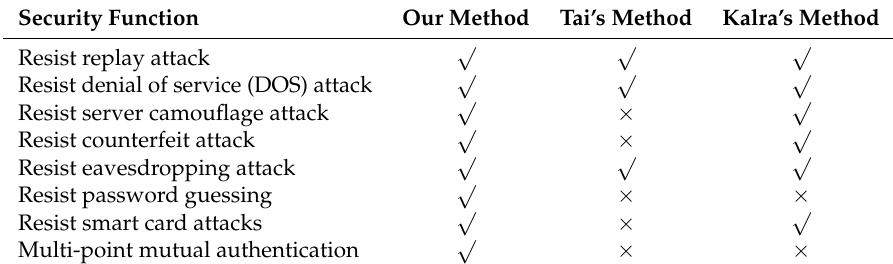
Table 2. Analysis of safety